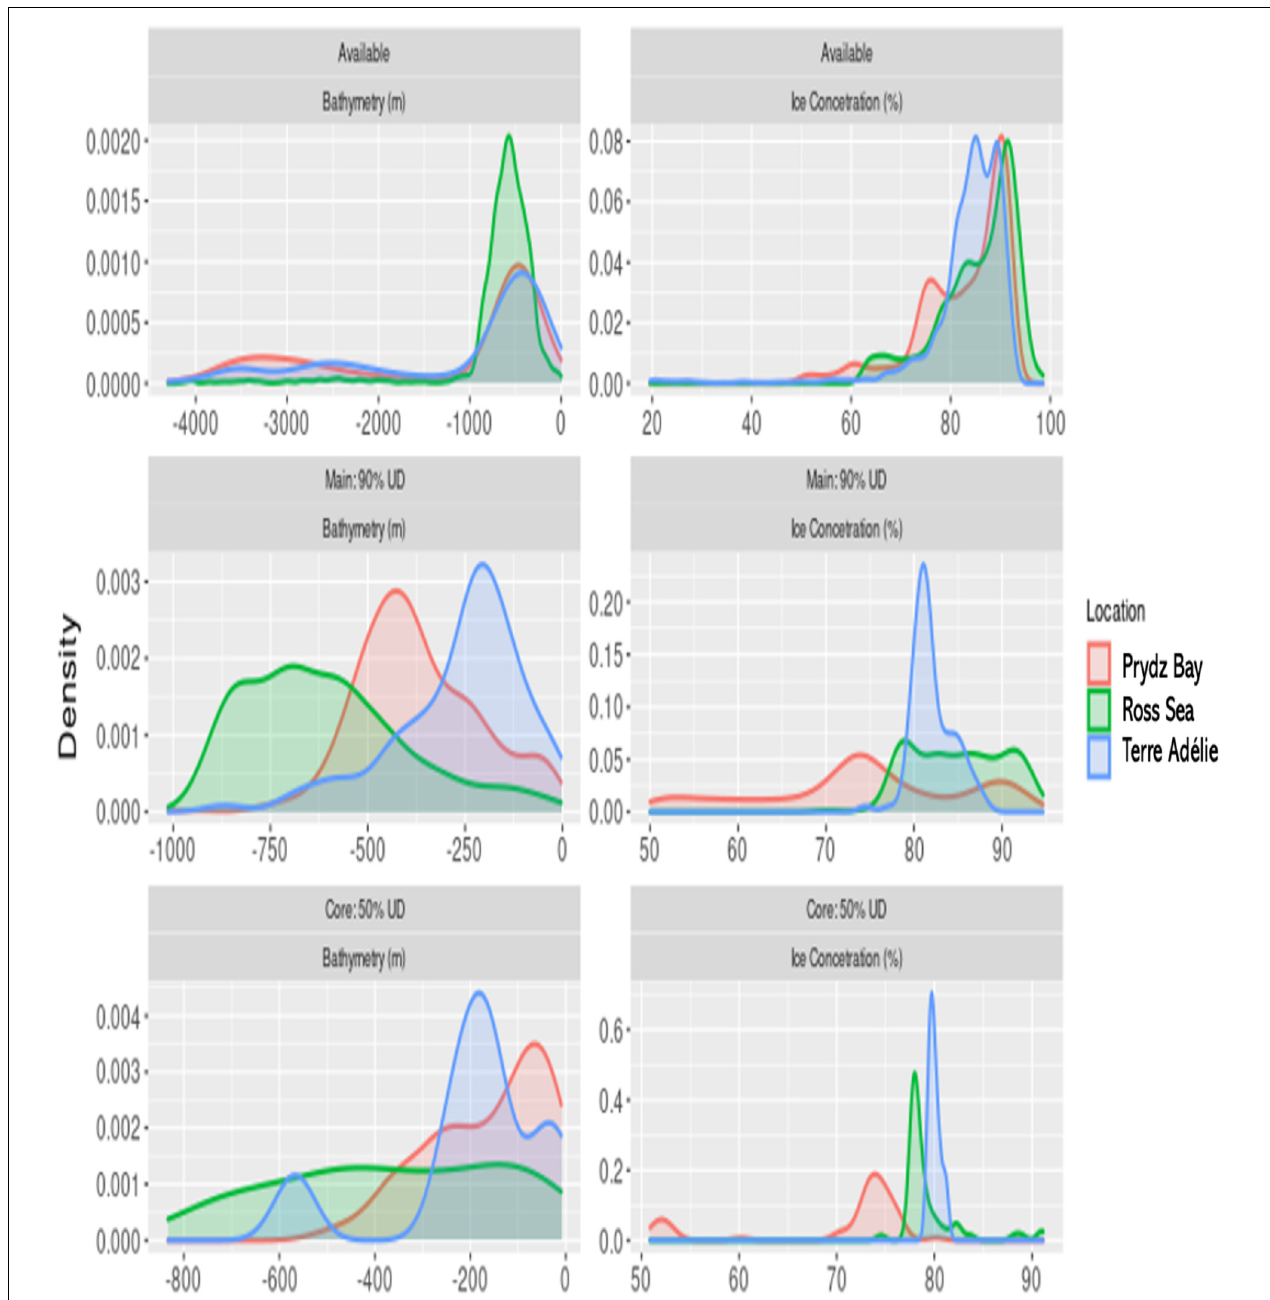
FIGURE 4 | Frequency distributions (expressed as densities) of the bathymetry (m) and ice concentrations (%) on July 30 comparing (i) the region potentially available to the seals (see Methods), (ii) the full sample Utilisation Distributions (UD s ) and (iii) the core UD s .